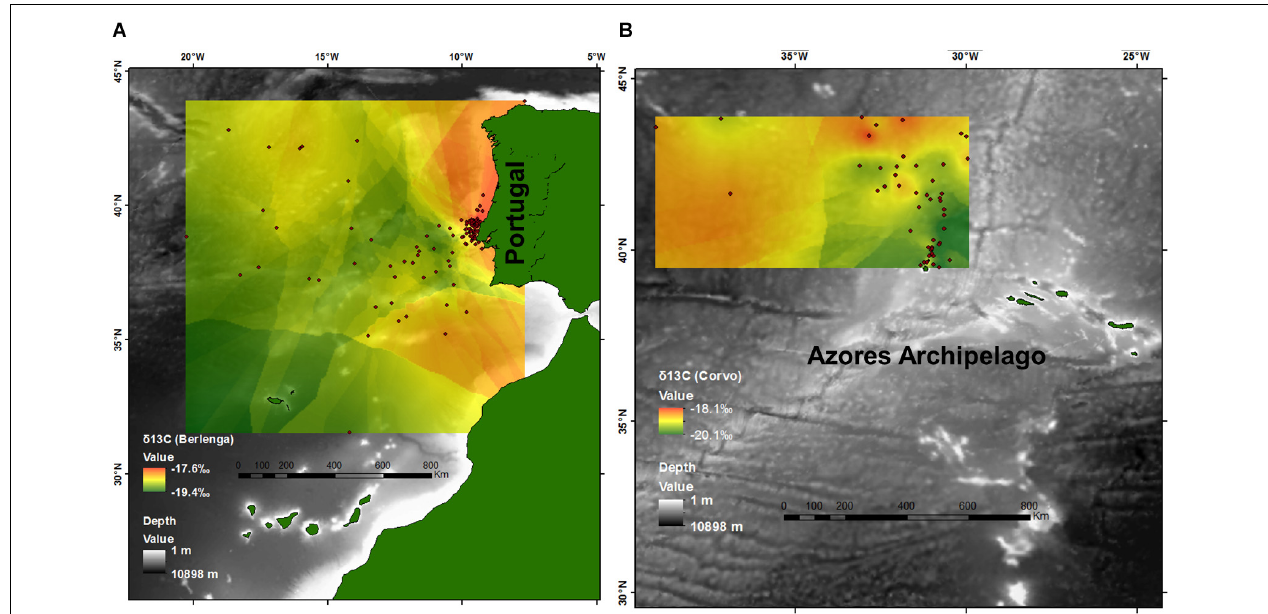
FIGURE 2 | Estimated isoscapes after kriging interpolation for the North Atlantic from (A) plasma δ 13 C values of the 142 Cory’s shearwaters ( Calonectris borealis ) tracked with GPS between 2010 and 2015 in Berlenga Island (neritic environment), and (B) plasma δ 13 C values of the 42 Cory’s shearwaters tracked with GPS in 2010 and 2015 in Corvo Island (oceanic environment). Points represent the mean latitude and longitude of feeding